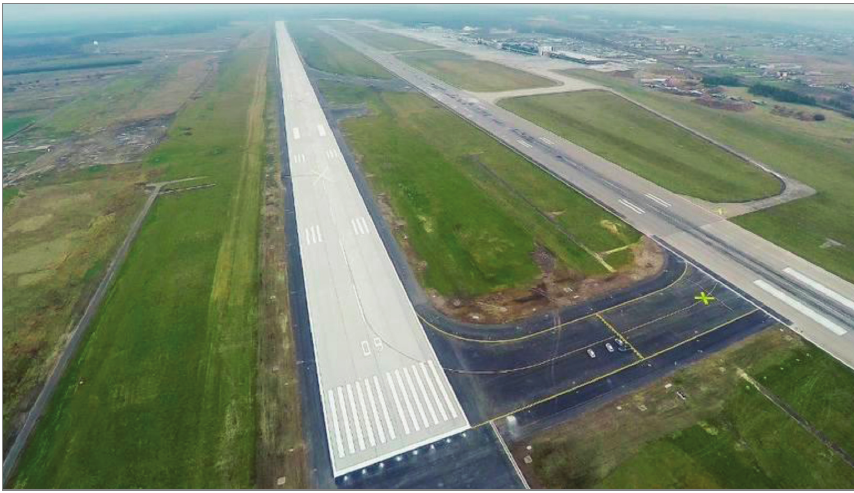
Fig. 1. New runway at the Katowice Airport built in 2014,